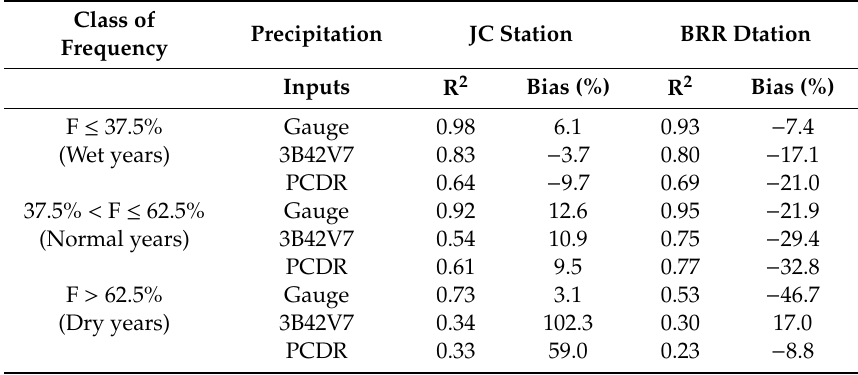
Table 5. Statistical indices of the simulated monthly streamflow using three precipitation inputs during the wet, normal, and dry years.